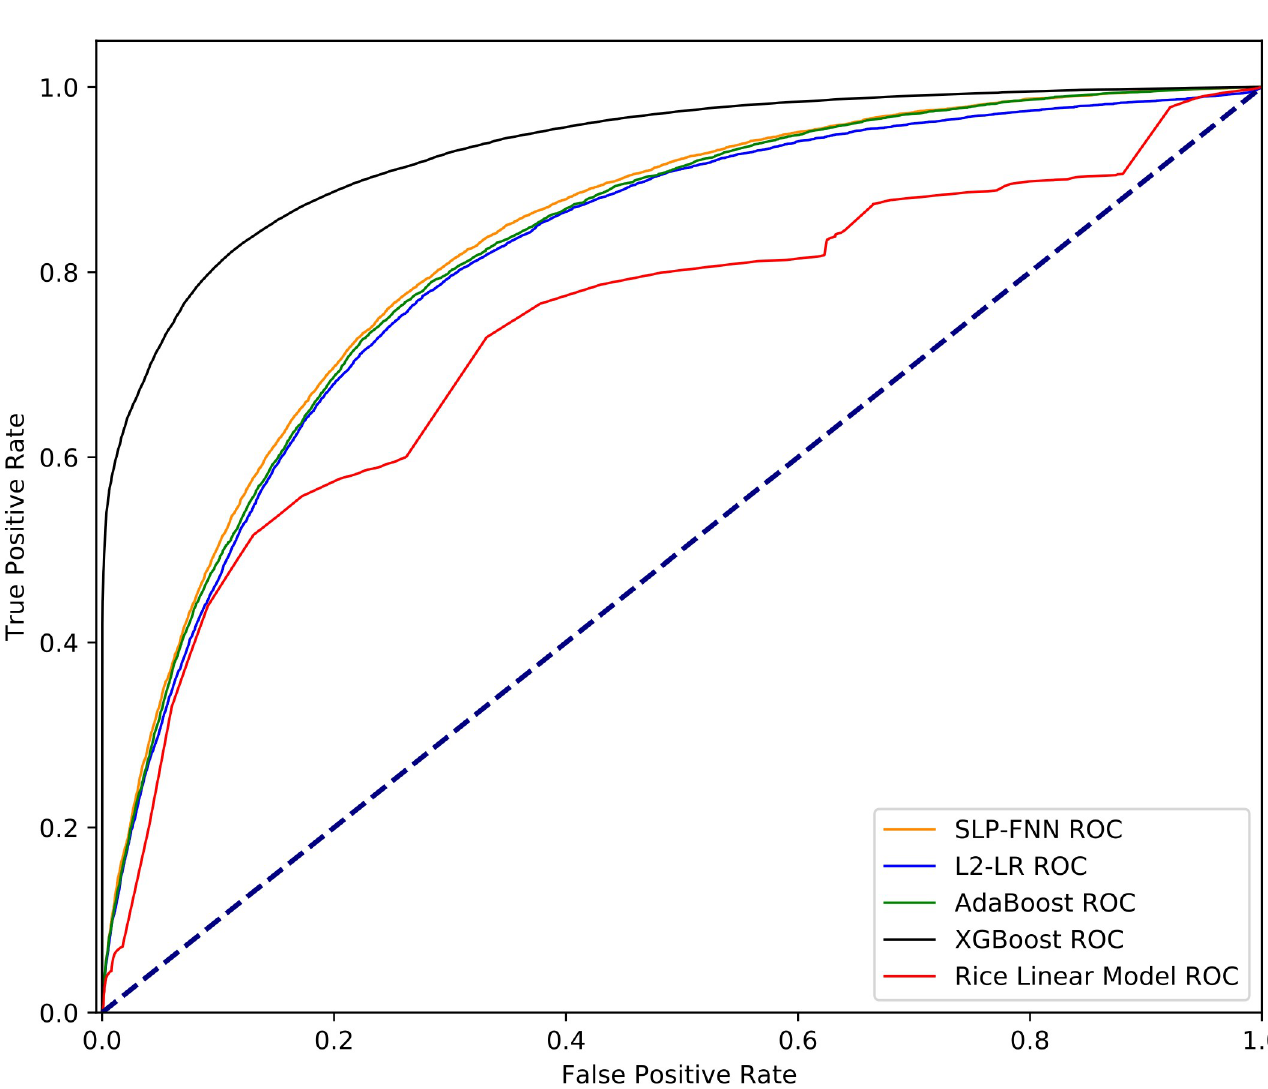
Fig 6. ROC curves of the applications of the four algorithms studied herein on the test dataset. According to the experimental results of the training set, the four machine learning algorithms and the Rice linear model are used to identify the performance of the minimum feature subset on the test set data, and the ROC curve of each algorithm is